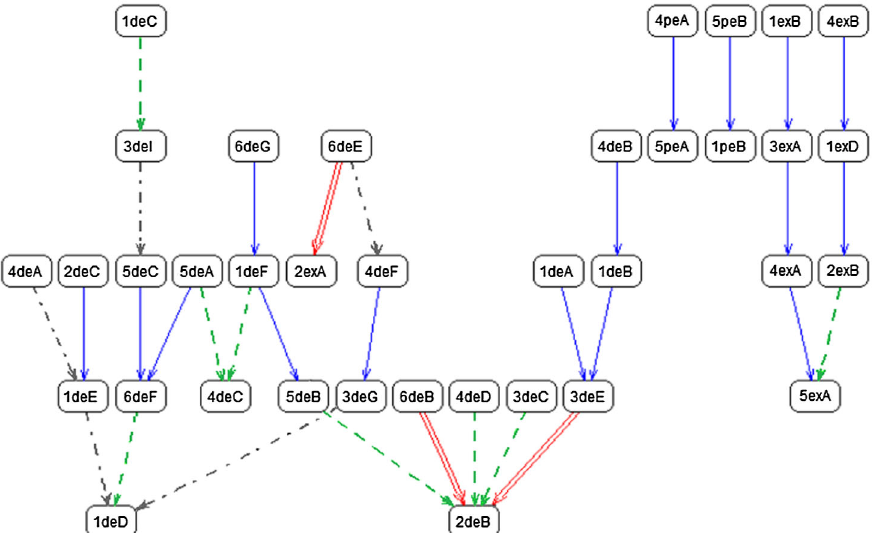
FIG. A1 (color online). Implicative graph of the answers to the test. Rectangles represent students’ answering strategies as reported in the a priori or a posteriori analysis in Appendix A. Red, double line arrows indicate an incidence of implication greater than 99% between two connected strategies; blue, solid arrows a 95% incidence; green, dashed arrows indicate a 90% incidence, and gray, dash- dotted lines an incidence of implication greater than 85%. Implications are to be read only between neighboring pairs of